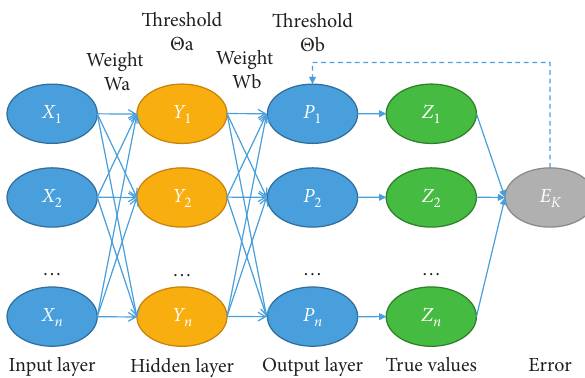
Figure 4: BP neural network